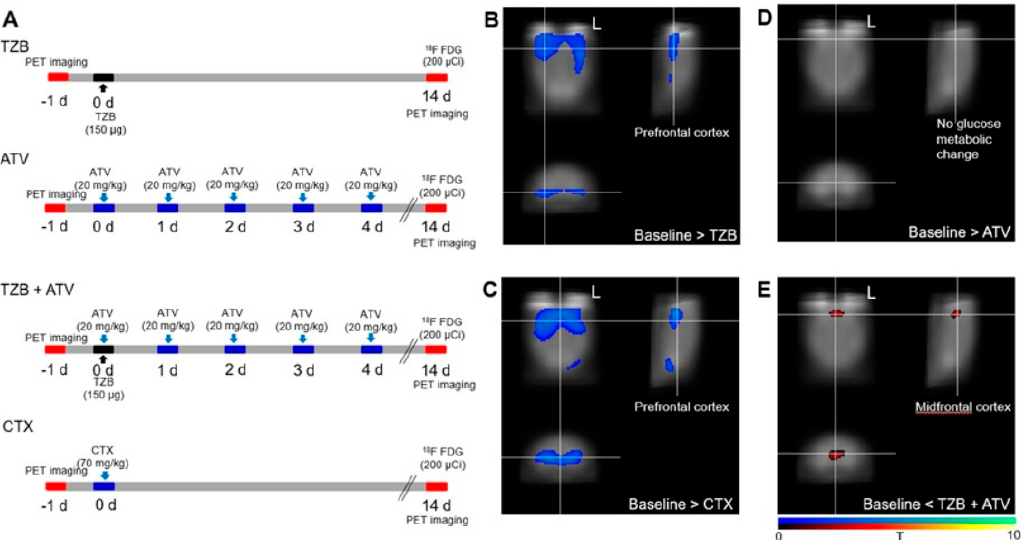
Figure 1. PET evidence of ATV effect during TZB therapy. ( A ) The experimental design. ( B ) A decrease in cerebral glucose metabolism was observed in the region of the bilateral frontal lobe following administration of TZB or ( C ) CTX relative to baseline ( p < 0.005). ( D ) No significant difference was found between ATV treatment and baseline ( p < 0.005). ( E ) An increase in cerebral glucose metabolism was observed in the region of the medial prefrontal cortex following administration of ATV ( p < 0.005). Decreased glucose metabolism after TZB treatment was rescued after administration of ATV. PET, positron emission imaging. FDG PET, 18 F-fluorodeoxyglucose positron emission tomography. ATV, atorvastatin. TZB, trastuzumab. CTX, cyclophosphamide. ( n = 10 per group).